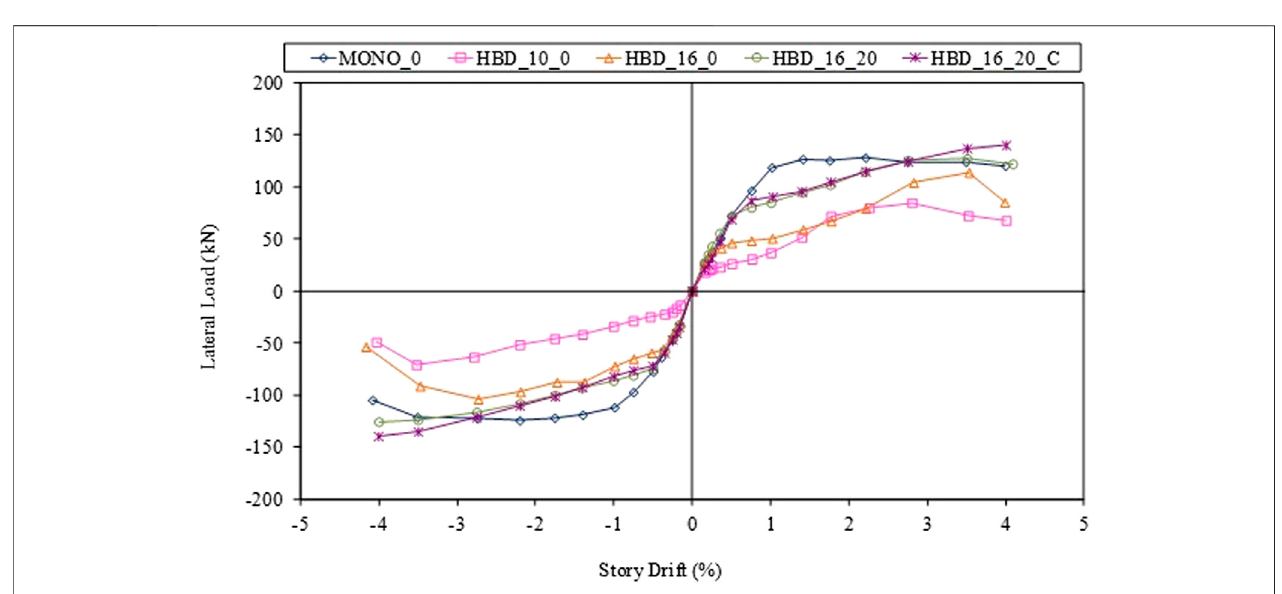
FIGURE 11 | Envelop curves of